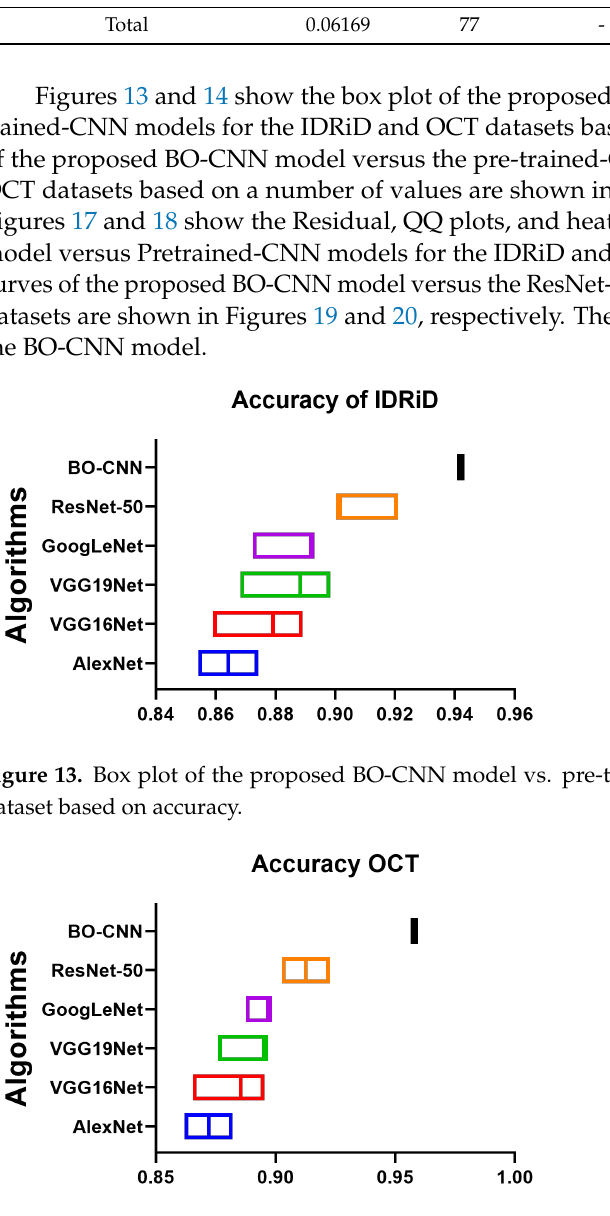
Figure 14. Box plot of the proposed BO-CNN model vs. pre-trained-CNN models for the OCT dataset based on